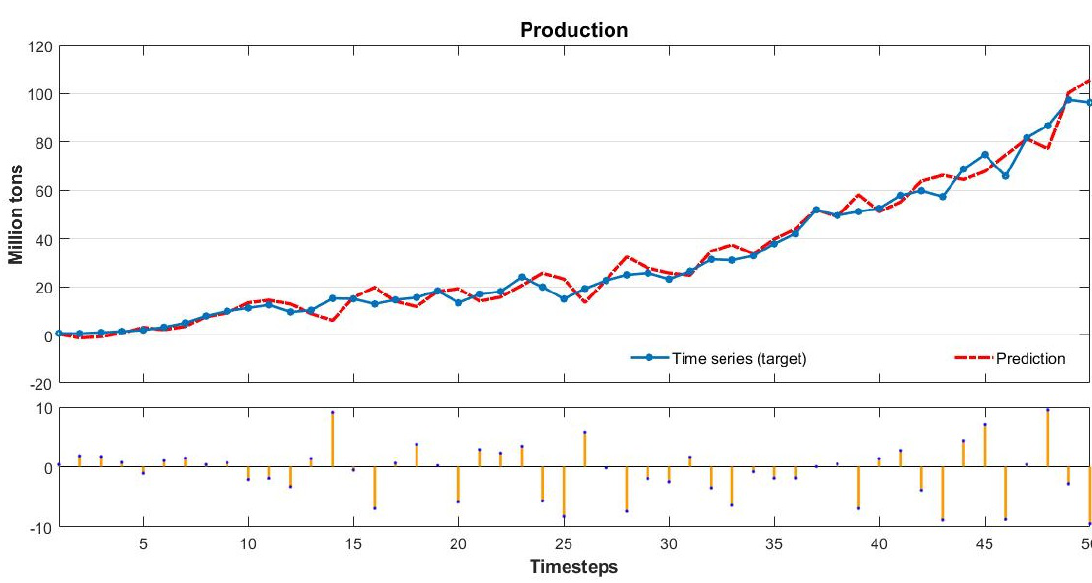
Figure 12. Multistep prediction of production using Matlab R2017b.